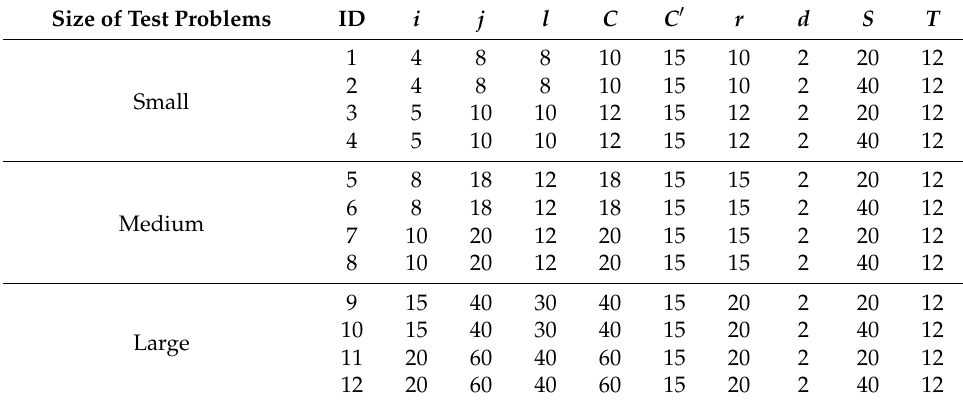
Table 4. Characteristics of test problems. Four test cases are generated for each small, medium, and large test problems. Each test case has a specific distinction to the other cases.